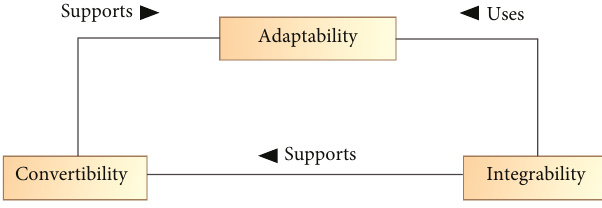
Figure 3: Associations between the core requirements in CPPSs. Table 1: Synthesis and reformulation of requirements on